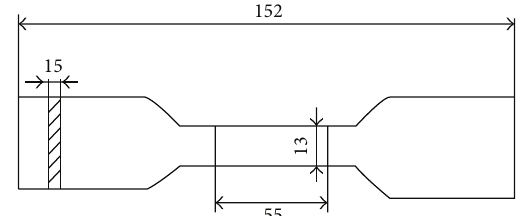
Figure 2: Dumbbell-shaped sample, with its dimensions according to PN-EN ISO: 1799:2009, used for the tensile strength test.